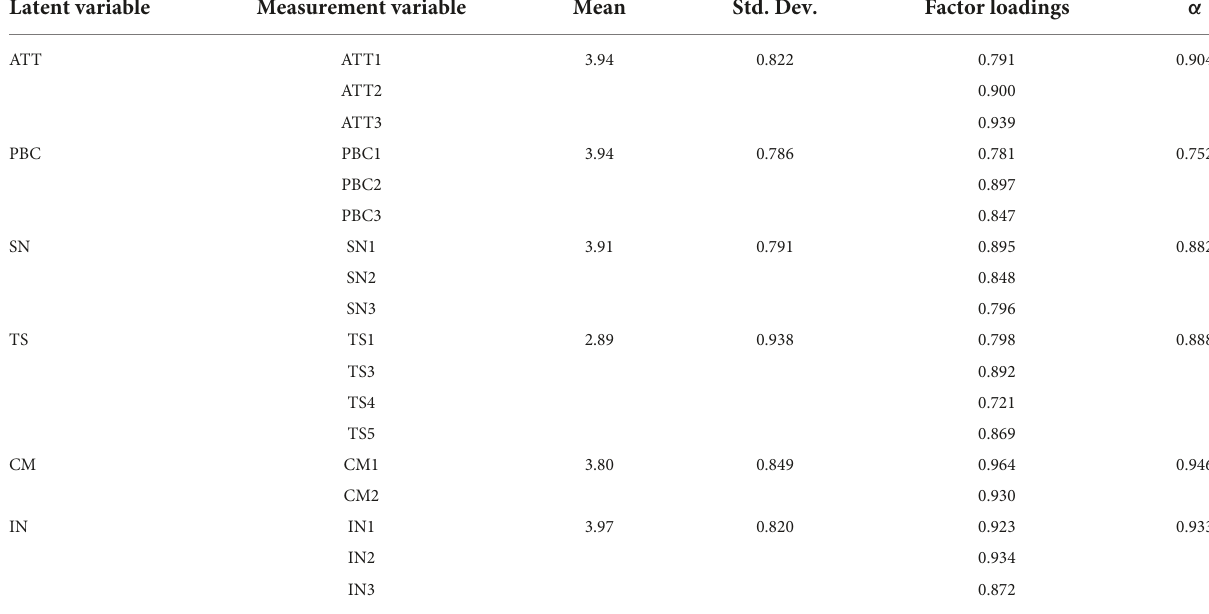
TABLE 2 Results of construct validity and reliability